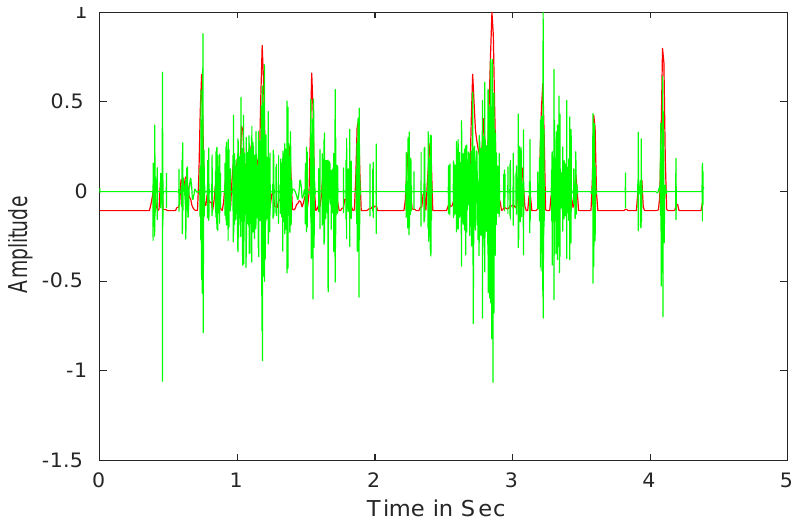
Figure 3. Heart sound signals envelope detection.